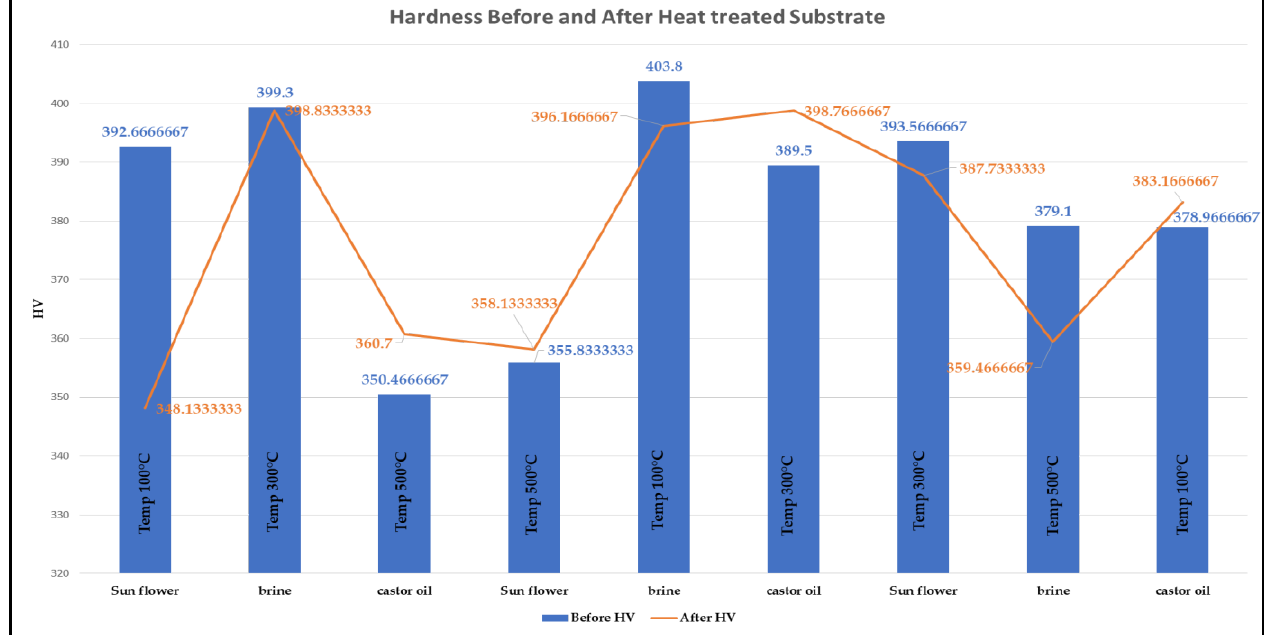
Figure 3. Hardness Before and After heat treatment of substrates.